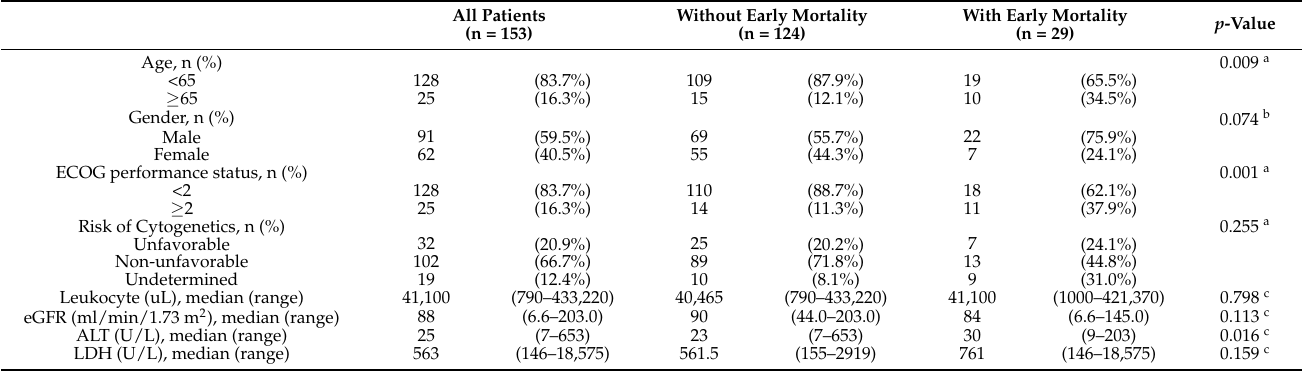
Table 1. Clinical characteristic comparison among patients with and without early mortality.